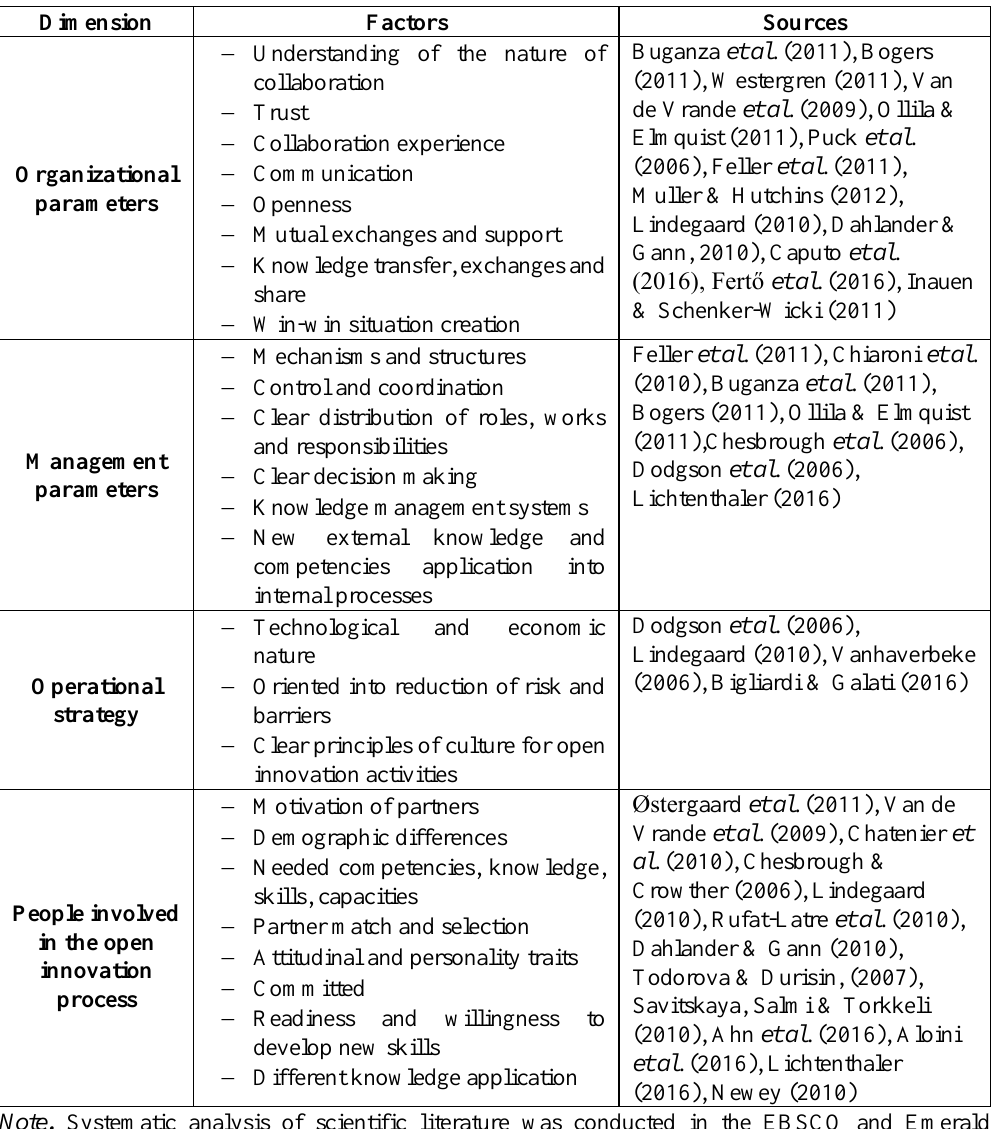
Table 1. Factors of open innovation process